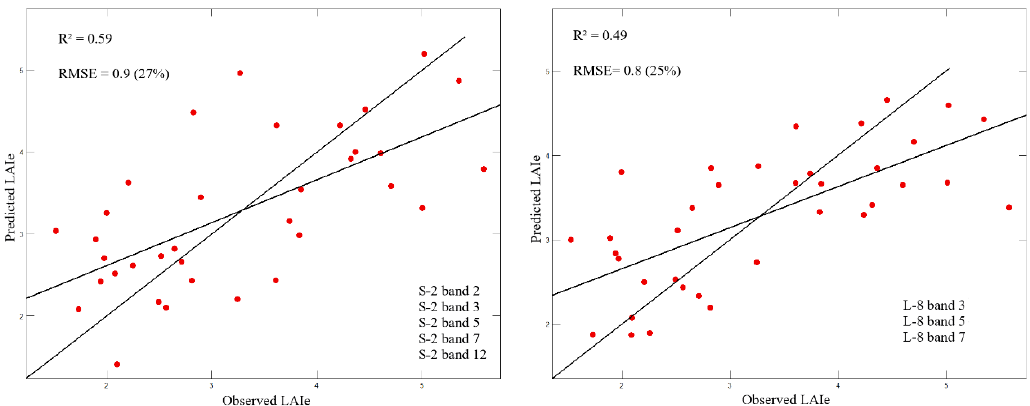
Figure 3. Observed vs. predicted LAI e of the best Sentinel-2 (S-2, right) and Landsat-8 (L-8, left) multiple linear regression models. RMSE: root-mean-square error.